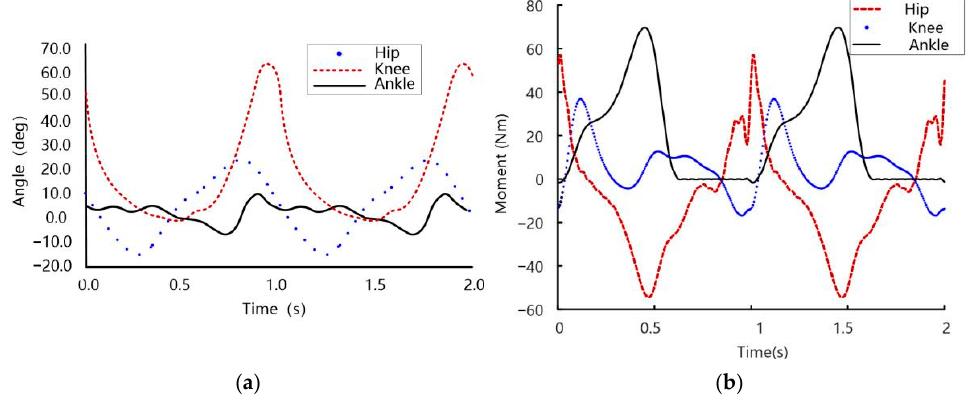
Figure 5. Curves in sagittal plane: ( a ) Joint angle and ( b ) Joint moment.